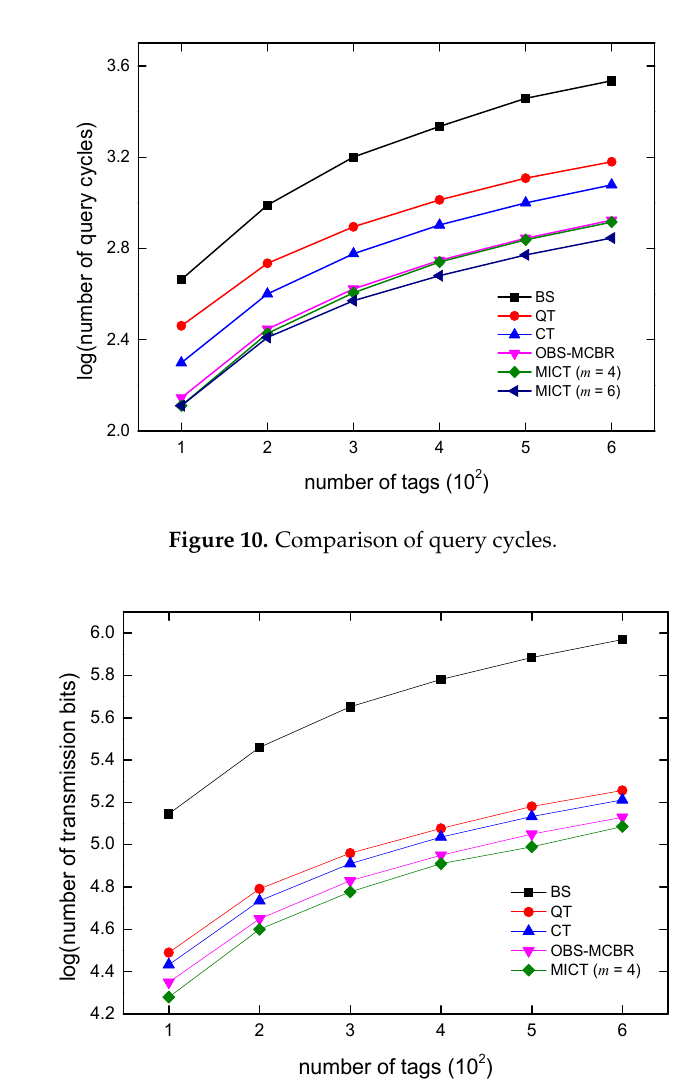
Figure 11. Comparison of data transmission.